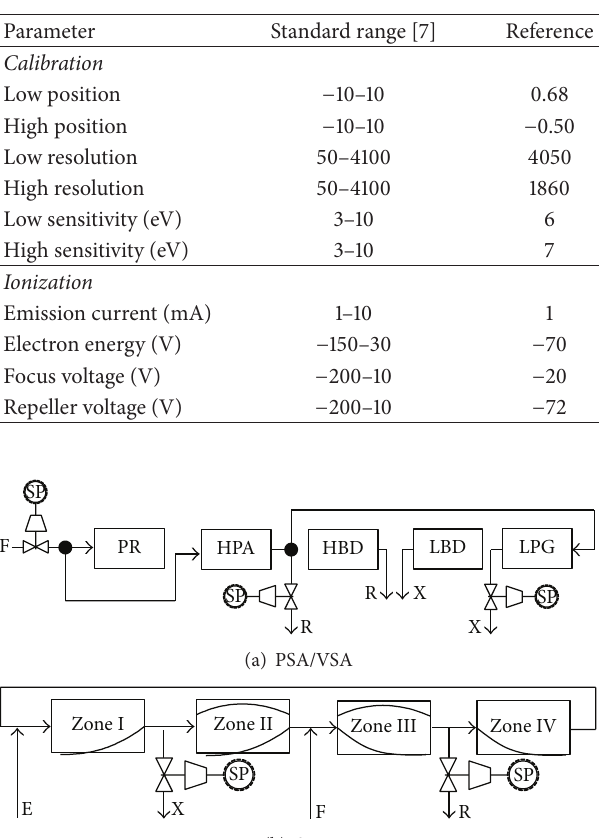
Table 1: Main range and user experimental references for the calibration and ionization internal parameters of the MS device employed in this work with mass range of 1–100amu.